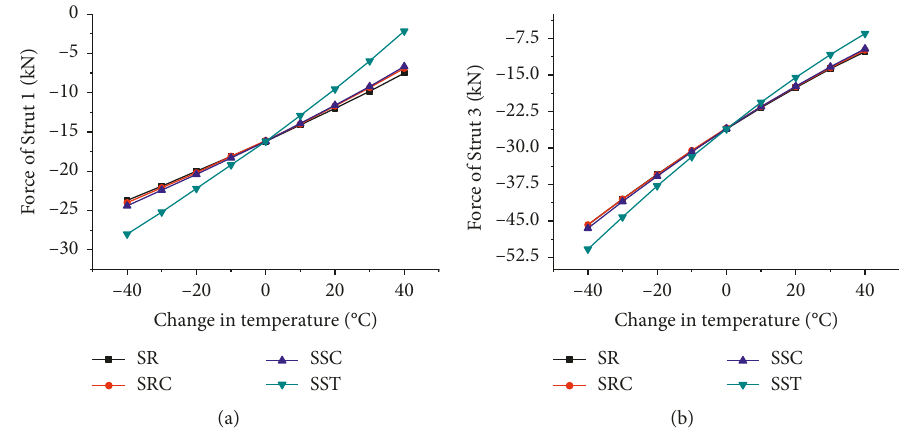
Figure 5: Relationship between the strut force and the temperature in the full-span load distribution. Change in the strut force of (a) Strut 1 and (b) Strut 3 with varying